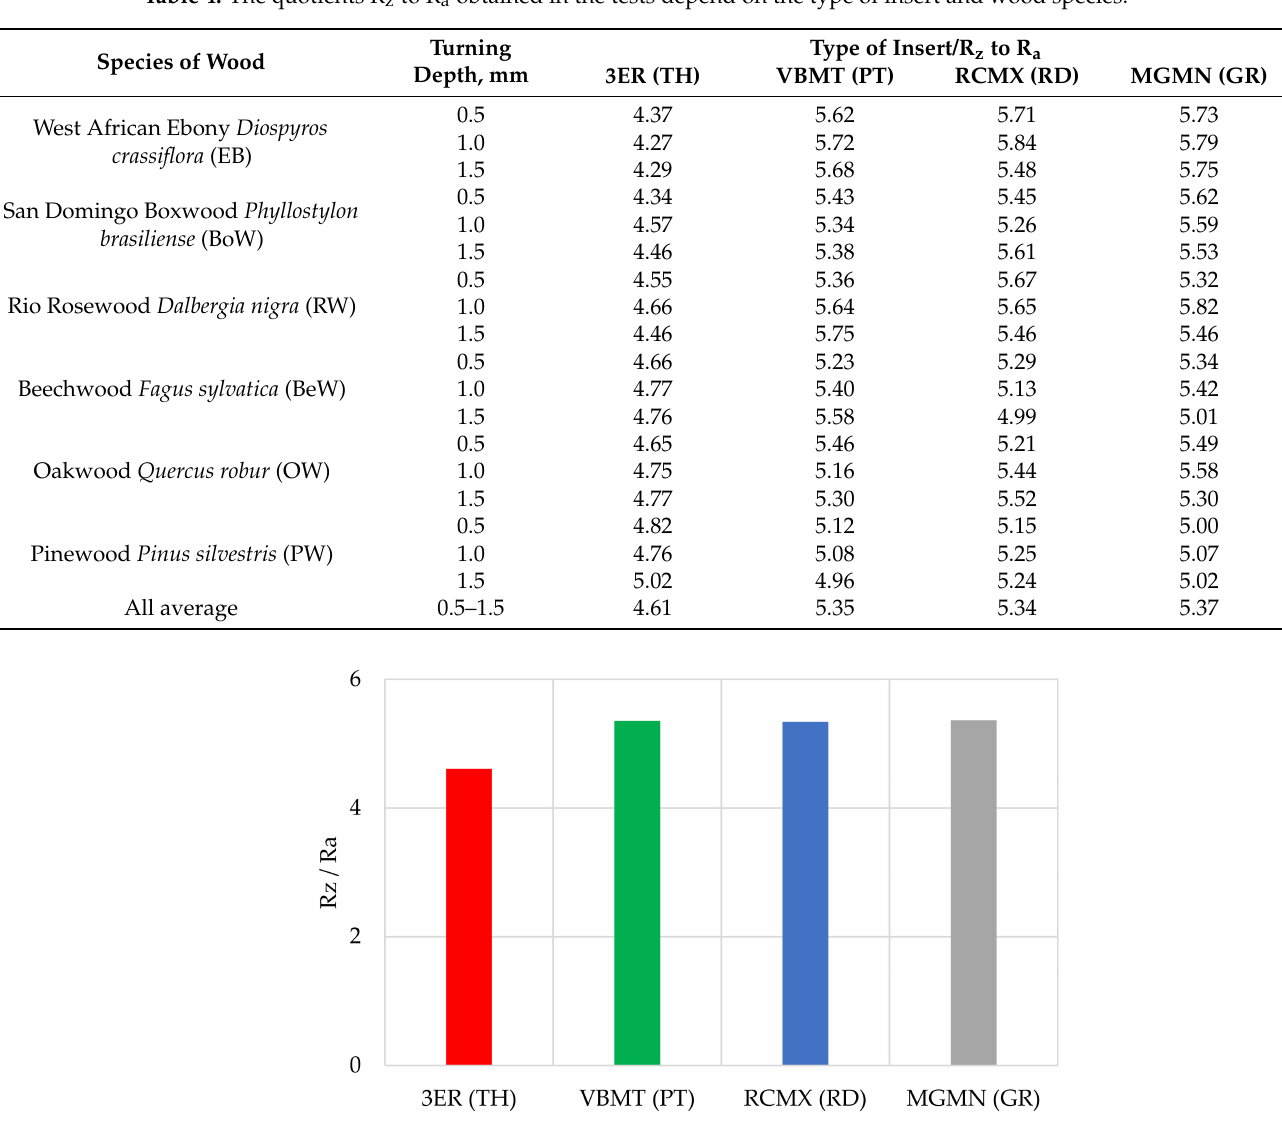
Figure 16. The quotients R z to R a obtained in all tests depending on the insert used.